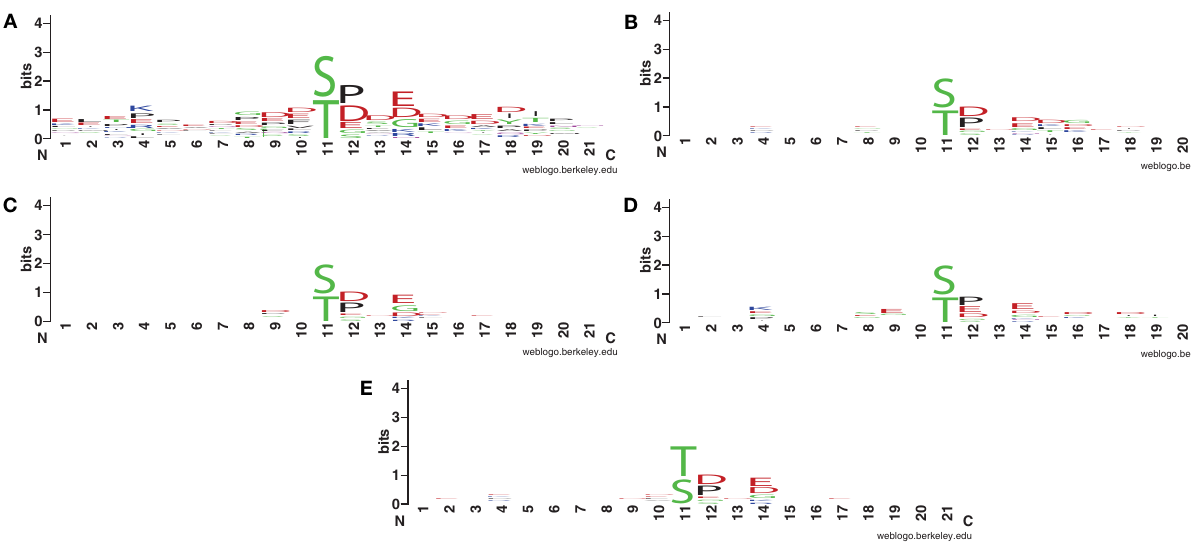
Frontiers in Plant Science | Plant